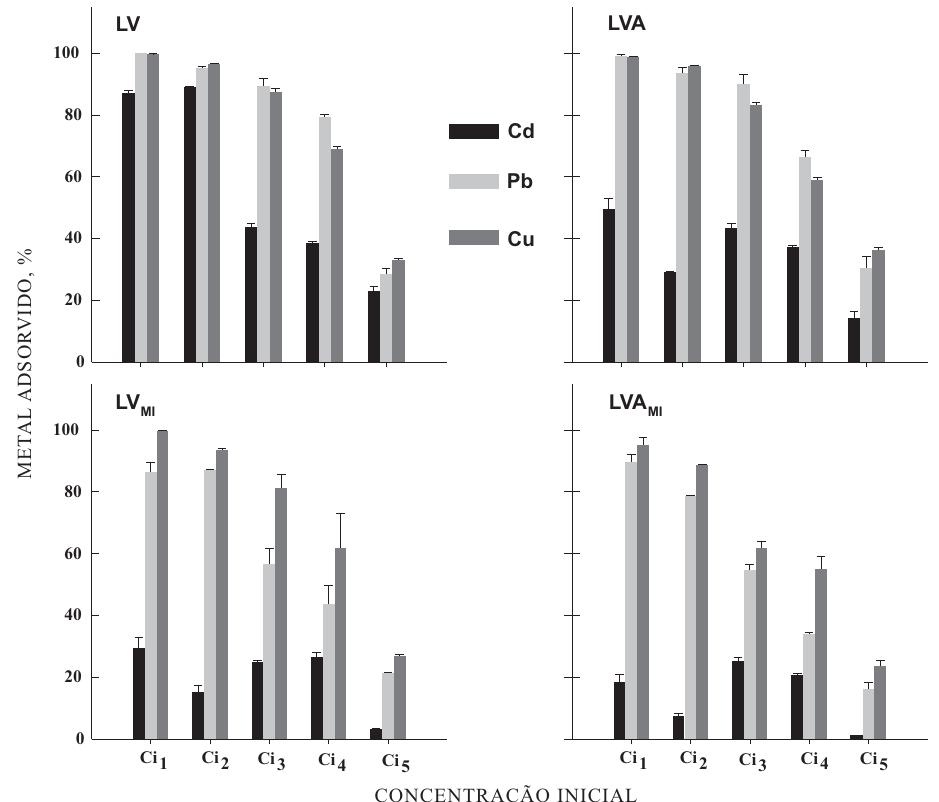
Figura 1. Porcentagem de Cd, Cu e Pb adsorvidas por amostras de Latossolo Vermelho (LV) e Latossolo Vermelho-Amarelo (LVA), em função da quantidade de metal adicionada (Ci 0,05; 0,10; 0,15; e 0,75 mmol L -1 , respectivamente) de cada metal, isolada e simultaneamente (LV LVA ). As colunas representam as médias e suas respectivas barras indicam o erro-padrão calculado MI para três